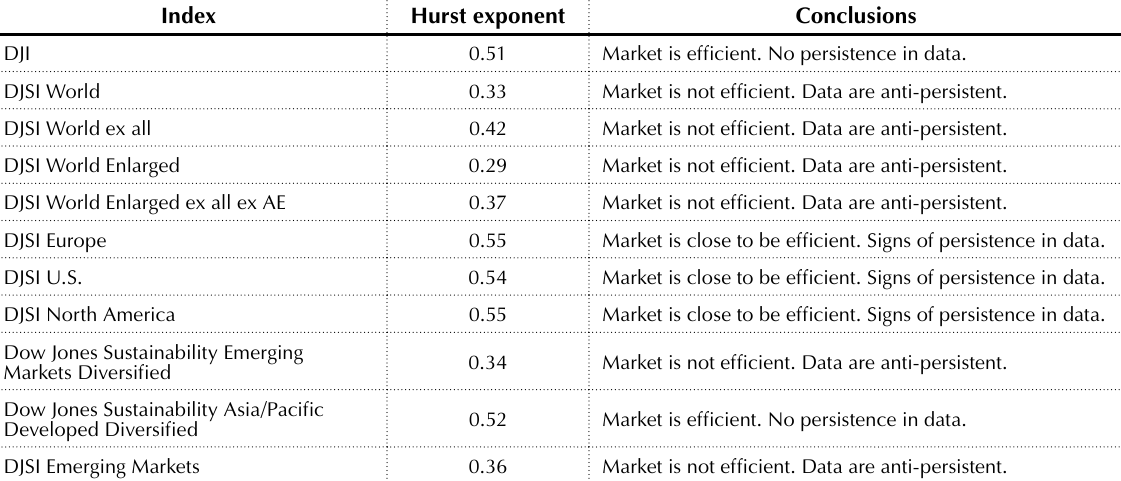
Table 2. Overall results of the Hurst exponent calculations for the Dow Jones Sustainability Indices and traditional Dow Jones Industrial Index *